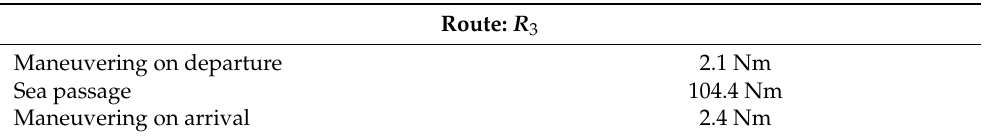
Table 16. Determined distances on the route R 3